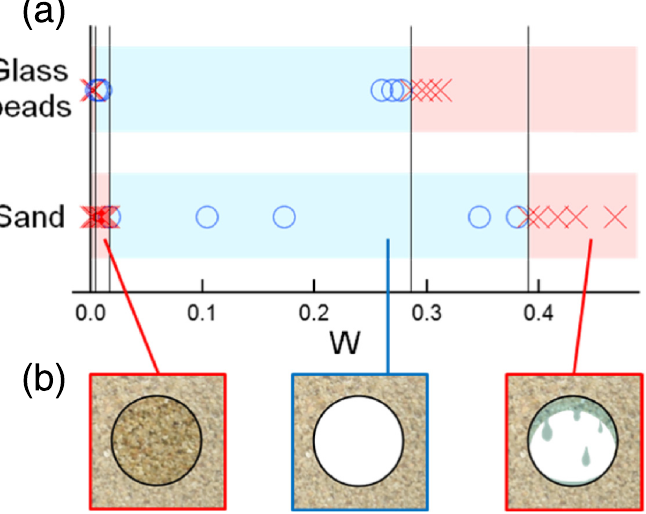
Fig 9. Experimental results on the initial stability of a tunnel in wet granular layer. Panles: (a) Static stability diagram for glass beads and sand. The ranges in water content where a stable tunnel structure can be maintained are indicated by circles and blue color. Unstable regions are indicated by exes and red color. Although a certain amount of liquid is necessary to keep a tunnel stable, too much liquid prevents the formation of a stable tunnel. (b) Three characteristic outcomes are depicted schematically (immediate collapse, stability, and collapse due to exuding